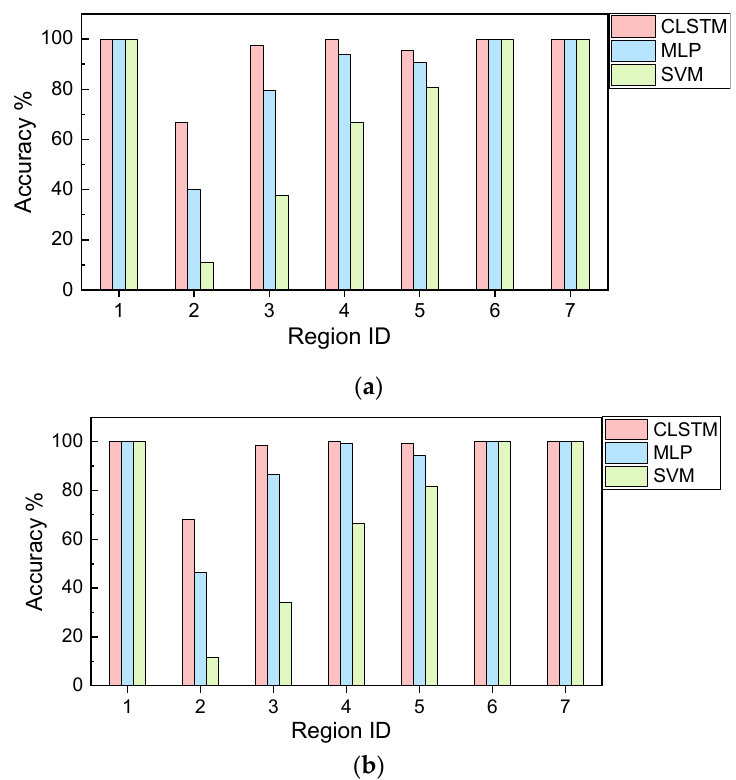
Figure 9. Cross-validation result: classification accuracy of ( a ) 100 data points per sample; ( b ) 40 data points per